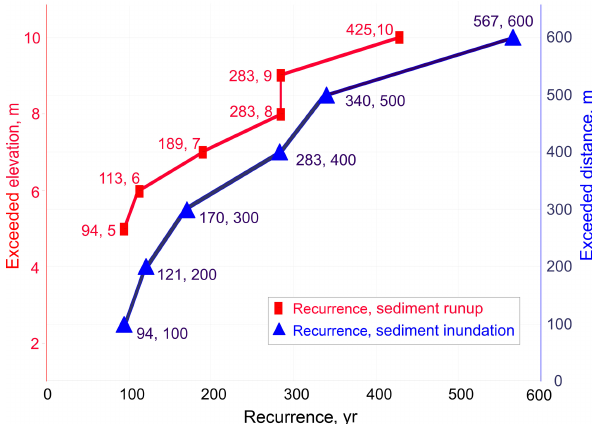
Figure 11. Tsunami (>5m) recurrence for exceeded elevations (sediment runup) and exceeded distances from shoreline (sediment inundation) based on tsunami deposits since KS 1 ( ∼ AD300) in south Kamchatsky Bay (for runup, integers of meters are shown; for inundation, multiples of 100m). For example, tsunamis with runup of 8–9m or more occur on average every 283 years. Tsunamis ex- ceeding inundation of 500m occur on average every 340 years. Re- call that runup and inundation are not paired (see